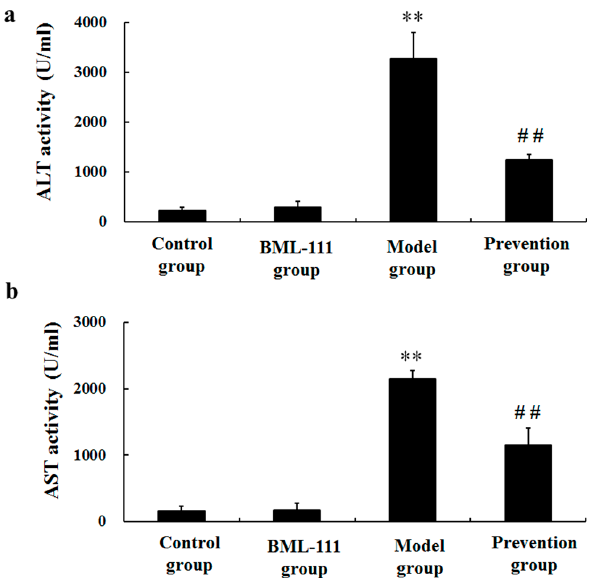
Figure 2. BML-111 repressed the activities of ( a ) ALT and ( b ) AST induced by LPS and D -GalN. Aspartate aminotransferase (AST) and alanine aminotransferase (ALT) were measured using kits according to the manufacturer’s protocols. ** p < 0.01 compared with the control group, ## p < 0.01 compared with the model group ( n = 6).